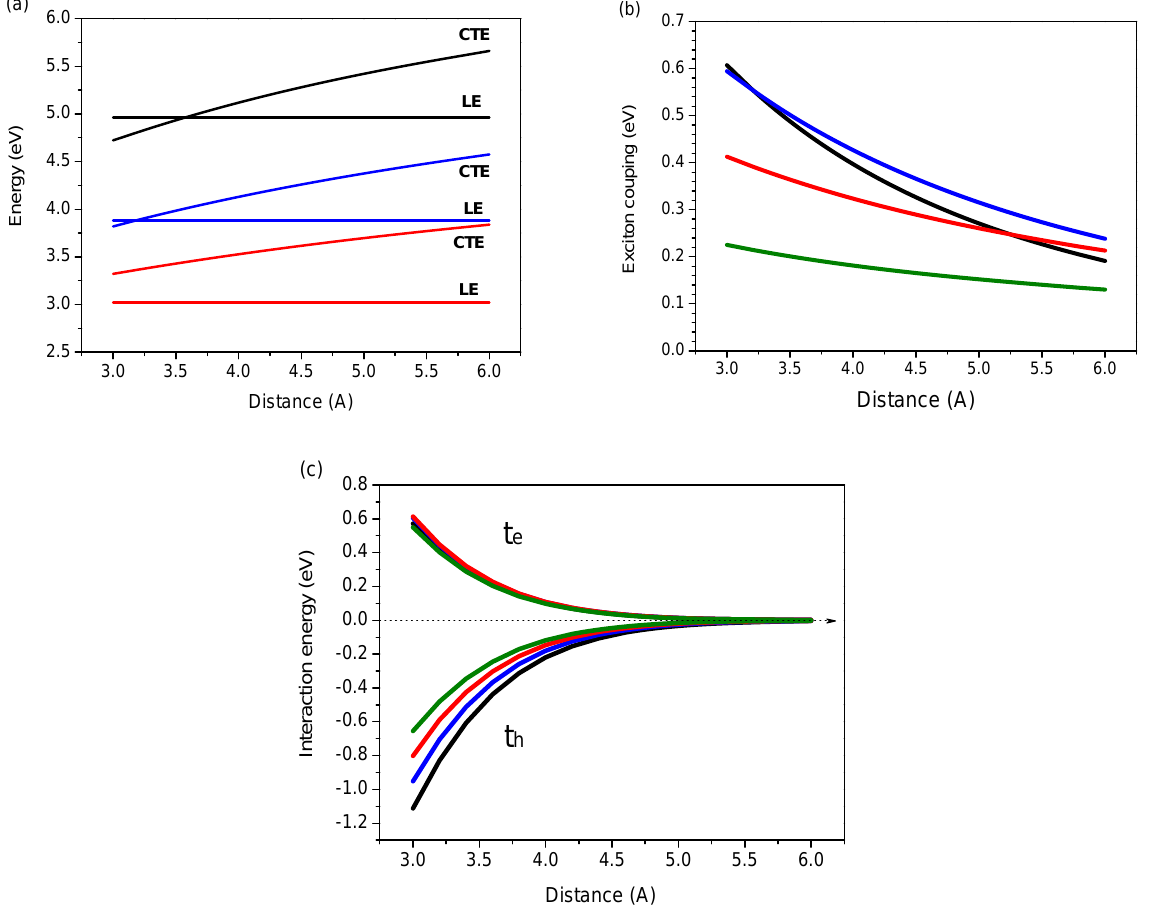
Figure 1. Distance dependence of the calculated (a) local exciton (LE) and charge-transfer exciton (CTE) energies (b) exciton coupling (2V) and (c) interaction energies of the ) and hole transfer (t ) of various polyene dimers, with N = 6 (black), 10 electron transfer (t e h (blue), 20 (red), and 40 (green) based on the four-orbital CM model (model 2 in Scheme 1) [46]. (Note that although we provide a detail distance dependence data, the van der Waals radius of carbon is 1.7 Å). Reproduced with permission from American Chemical